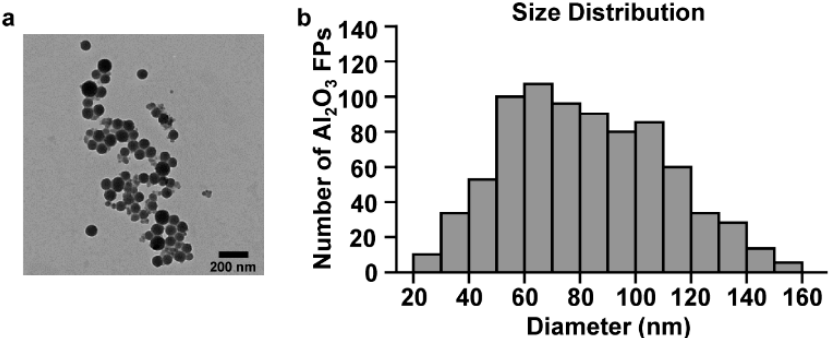
Figure 1. Characteristics of the aluminum oxide fine particles (Al 2 O 3 FPs). ( a ) Transmission electron micrograph, ( b ) size distribution of Al 2 O 3 FPs.